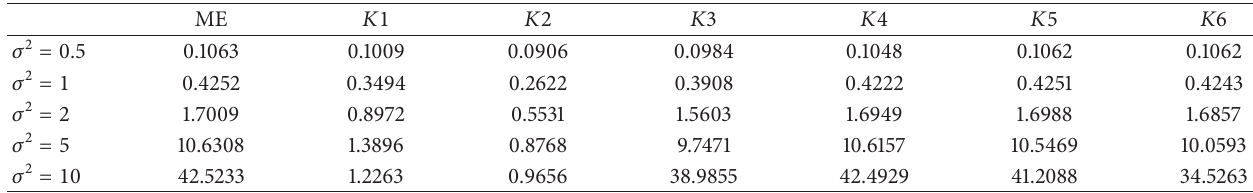
Table 20: Estimated MSE with 𝑛 = 50 , 𝑝 = 8 , and 𝛾 = 0.99